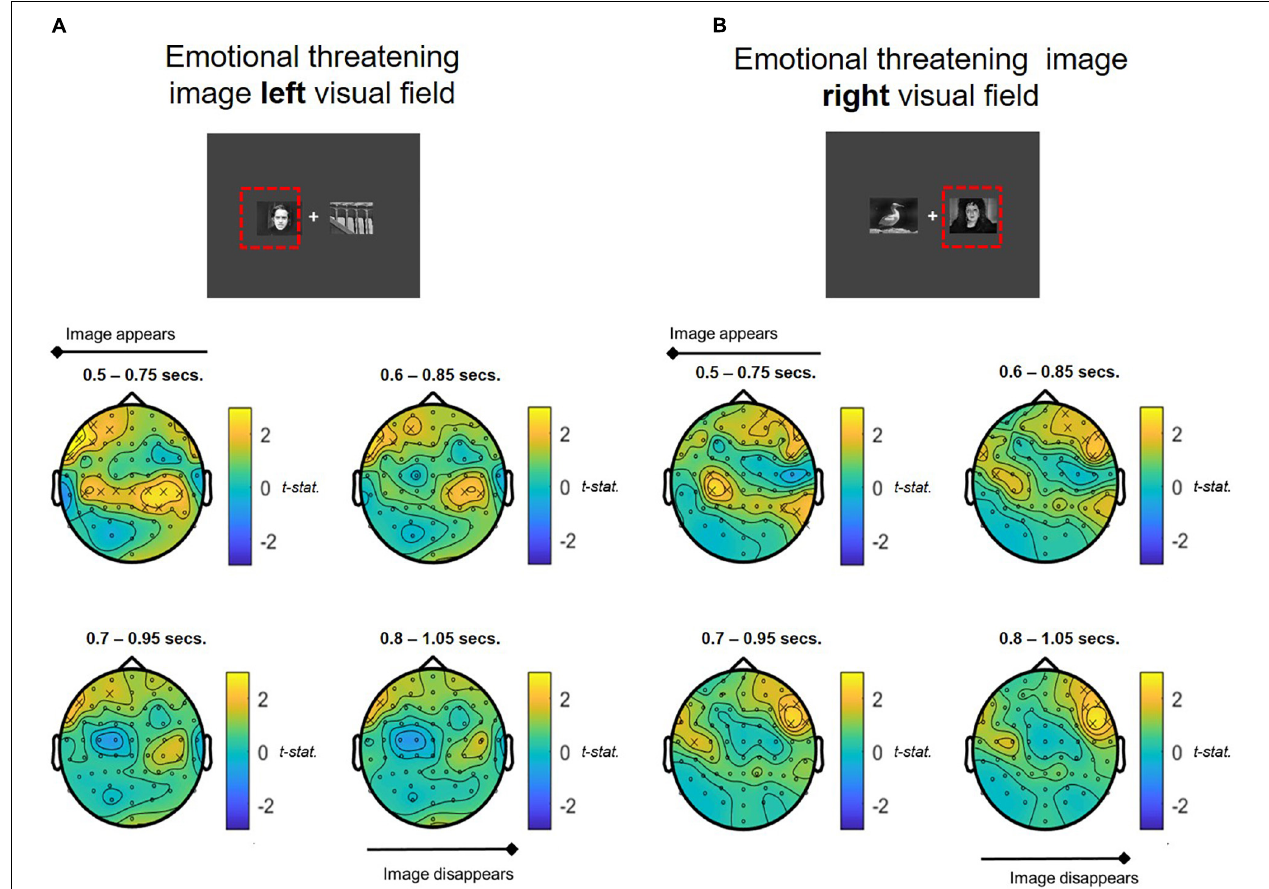
FIGURE 5 | T-statistic map of alpha band power differences between COMBINED and PLACEBO treatments during presentation of emotionally threatening images shown in the (A) LEFT and (B) RIGHT visual fields. Values > 0 indicate COMBINED treatment alpha values are higher than PLACEBO treatment. Significant electrodes ( p < 0.05) marked with an x . Each figure depicts a series of T -tests along the time course of the presentation of the images (0.5–1.05 s, in 0.1 s steps, 0.25 s sample